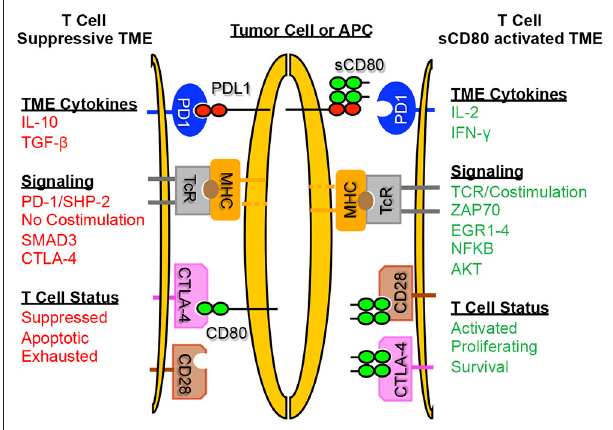
FIGURE 3 | Soluble CD80 activates T cells, blocks PD-1 mediated immune suppression, and promotes anti-tumor immunity. sCD80 acts as a checkpoint inhibitor by blocking PD-L1 on tumor cells and antigen presenting cells while simultaneously binding and activating T cells through CD28. T cells activated by sCD80 have increased IFN γ and IL-2 production and upregulate TCR and CD28 signaling, resulting in an immune-reactive tumor microenvironment with T cell killing of target tumor